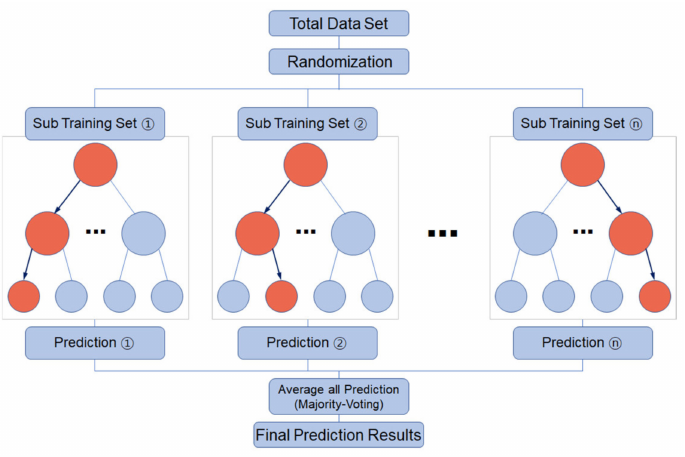
Figure 2. Concept of random